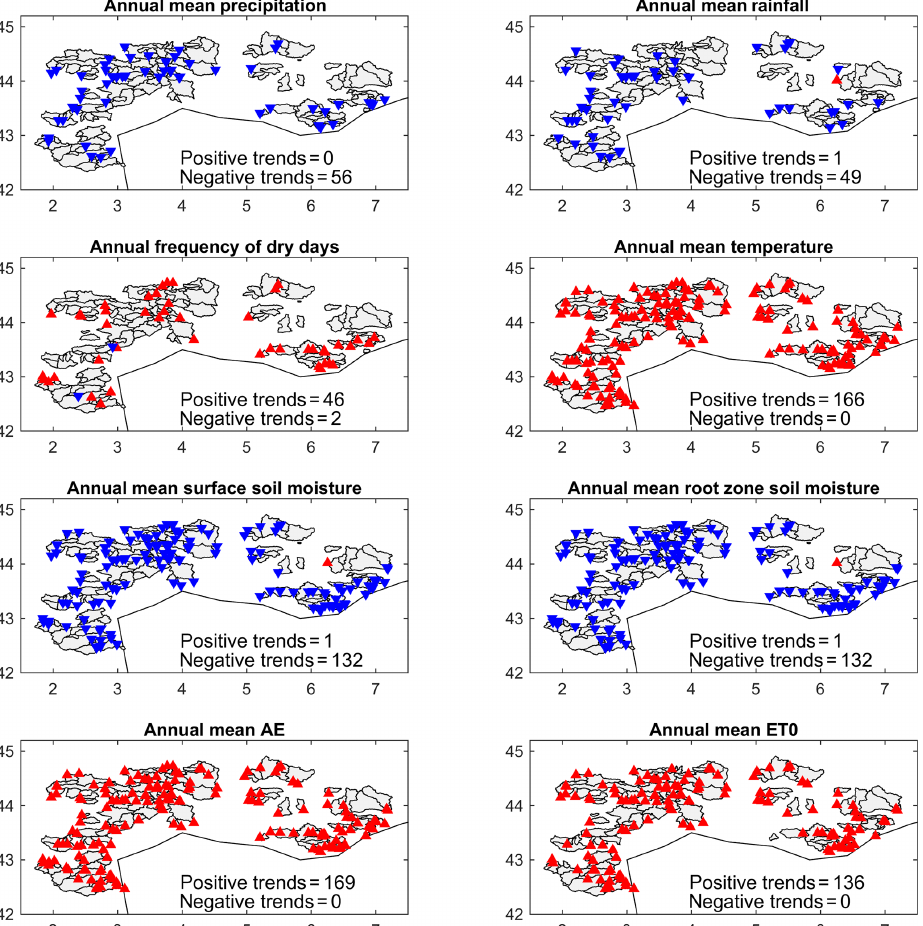
Figure 2. Significant annual trends at the 10% level (Mann–Kendall test) between 1958 and 2018 in precipitation, rainfall, frequency of dry days (with precipitation below 1mm), temperature, soil moisture, actual evapotranspiration (AE) and reference evapotranspiration